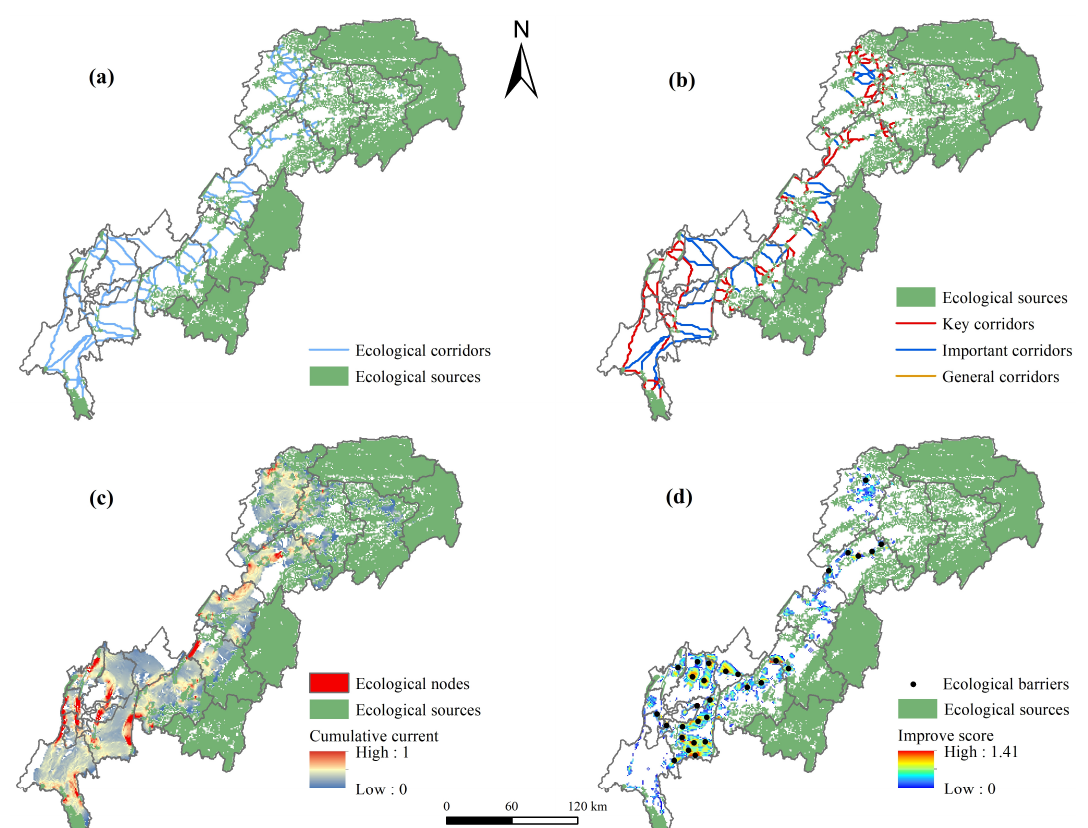
Figure 8. Spatial distribution of ecological corridors ( a ), corridors classification ( b ), nodes ( c ), and barriers ( d ).